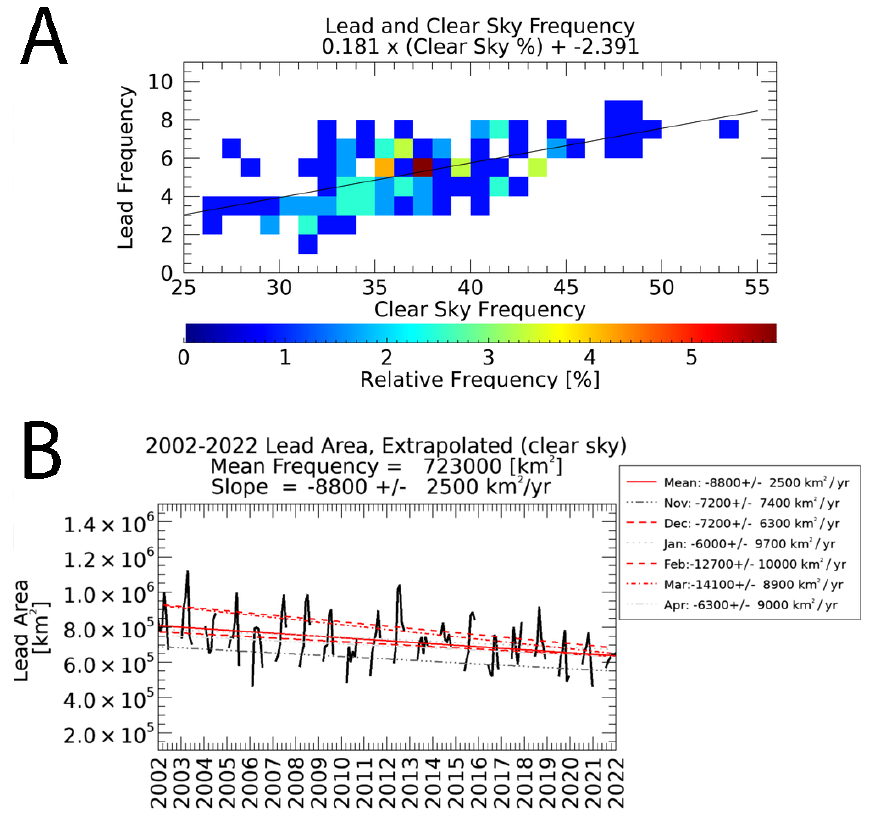
Figure 9. The relationship between clear sky frequency and lead detection is shown in Panel ( A ), with a density plot of the monthly percentage of clear sky observations and the corresponding average monthly lead detection frequency for the winter months between November 2002 through April 2022. In Panel ( B ), the extrapolated lead area is shown over the same time period. Statistically significant decreases are in red, and shades of gray are used for months with no statistically significant trend.